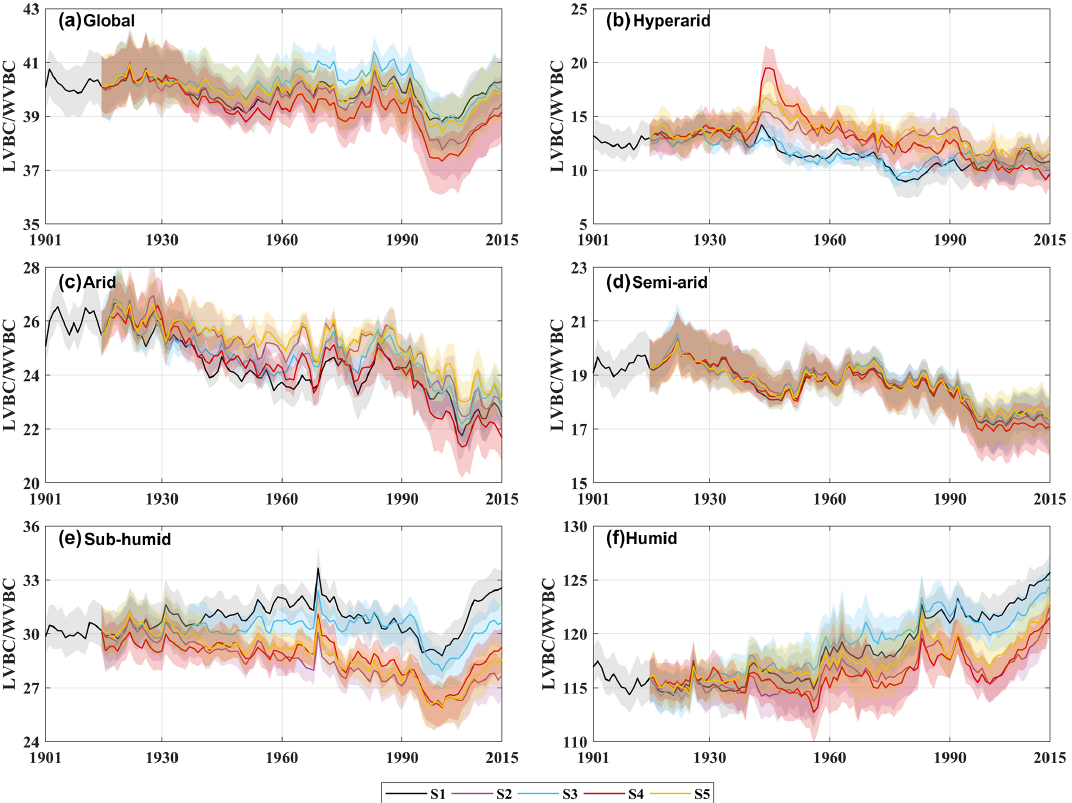
Figure 11. Temporal fluctuations in carbon stock dynamics in vegetation biomass in different factorial simulations. Black indicates historical factorial simulation from 1901–2015, green indicates the CO 2 -driven factorial simulation, blue indicates the precipitation-driven factorial simulation, red indicates the temperature-driven factorial simulation, and yellow indicates radiation-driven factorial simulation. Uncertainty bounds are provided as shaded areas and reflect the intra-annual fluctuation ( ± 1s.d.). (a) Modelled trend of LVBC / WVBC ratio in